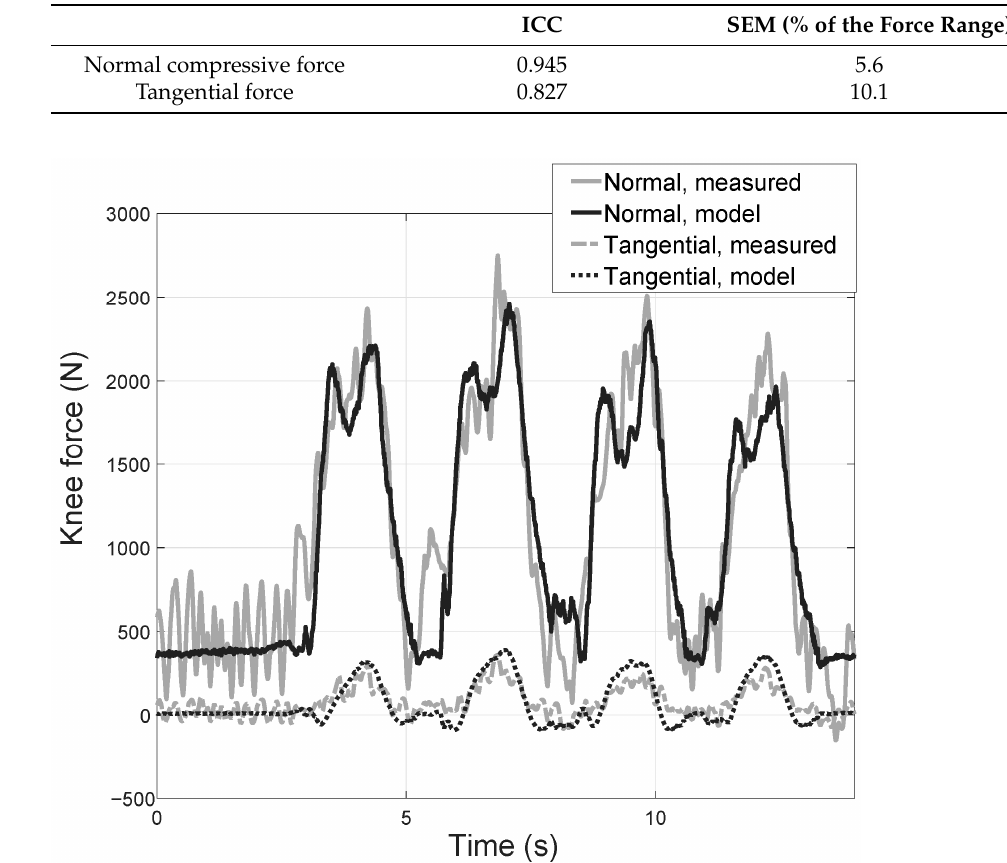
Figure 6. Tibial plateau forces as estimated by the simplified quasi-static model and as measured directly by means of an instrumented prosthesis (Data adapted from Ref. [26]. 2011 Wiley).